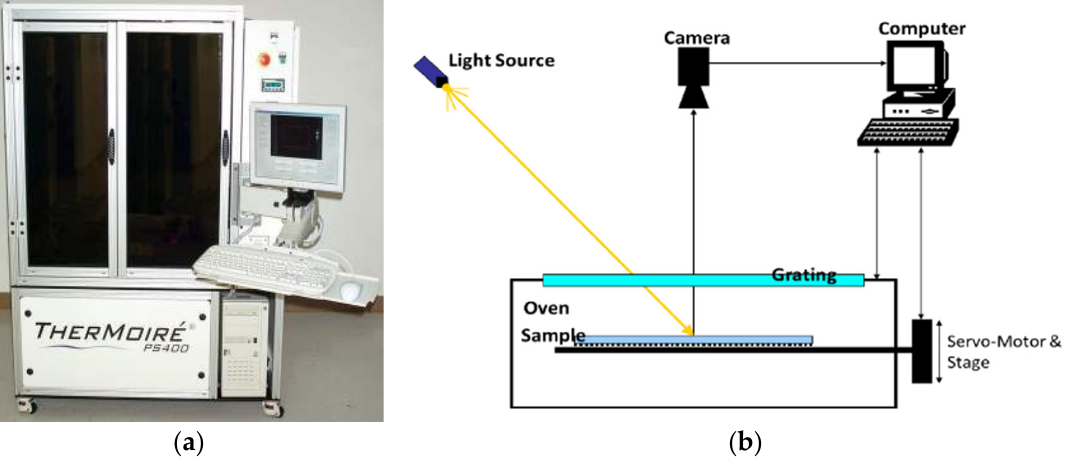
Figure 4. ( a ) Commercial shadow moiré system, and ( b ) schematic of the principle of out-of-plane deformation measurement in the system.